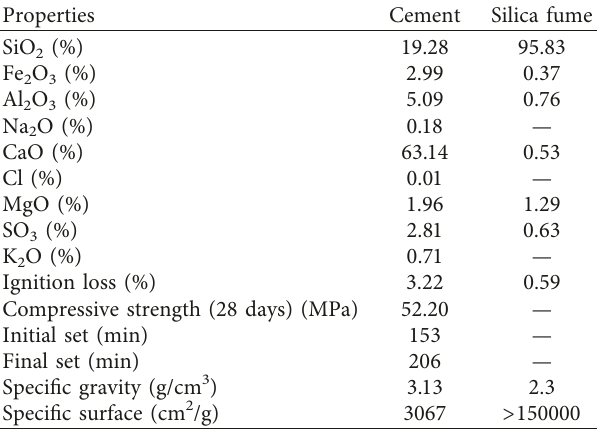
Table 1: Chemical, physical, and mechanical properties of